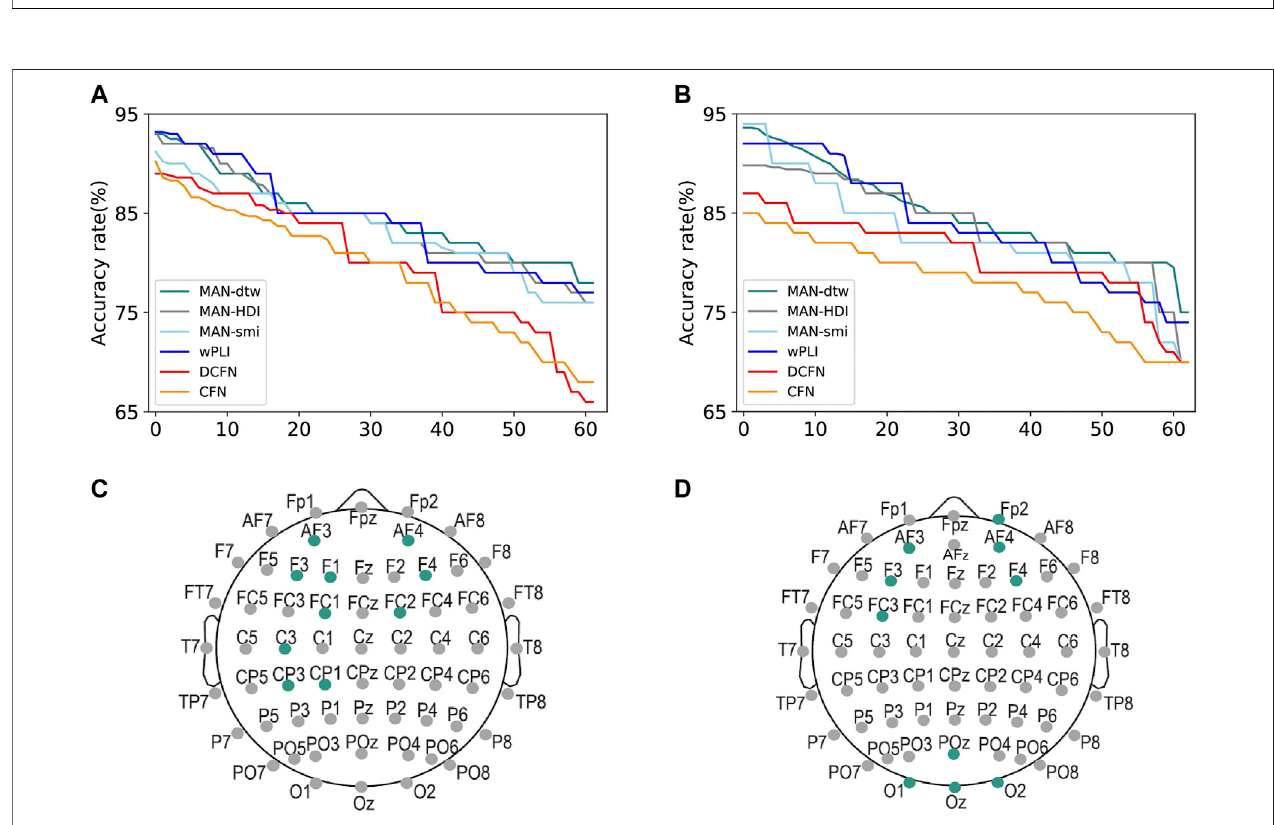
FIGURE 5 | Important channels and their locations for detecting fatigue status (A,C) and schizophrenia (B,D) . The colored points in (C,D) represent the corresponding positions.